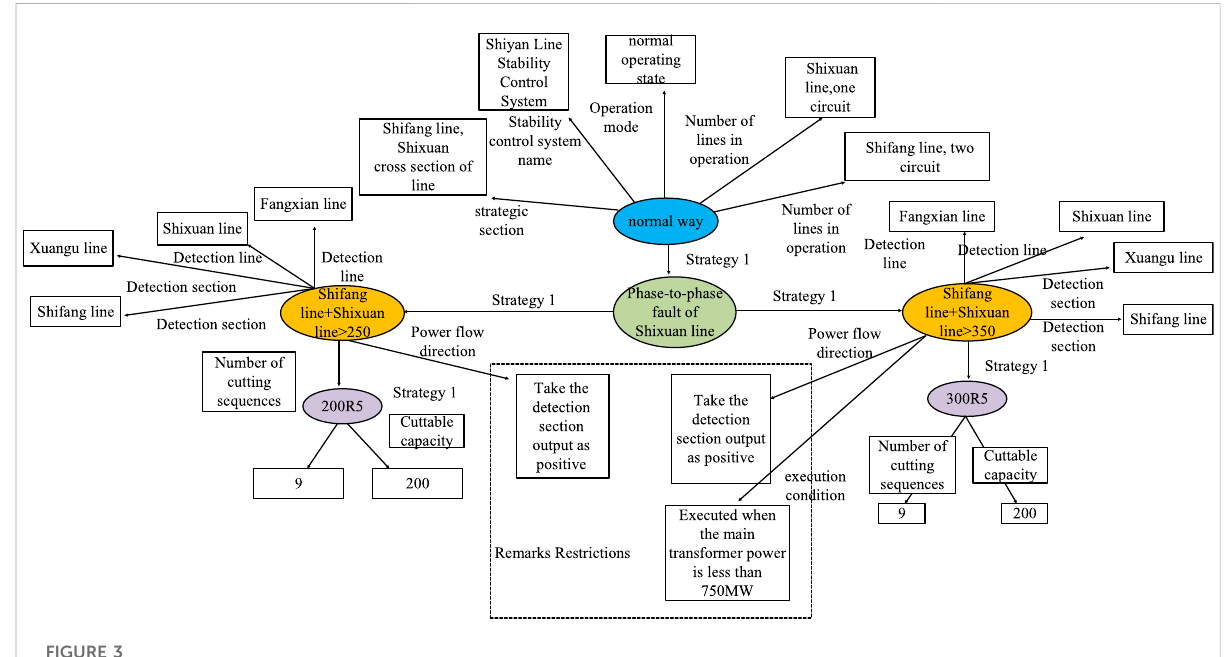
FIGURE 3 Example of the security and stability control system